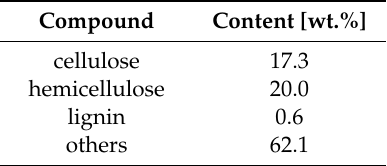
Table 1. Fibers analysis of spent sugar beets